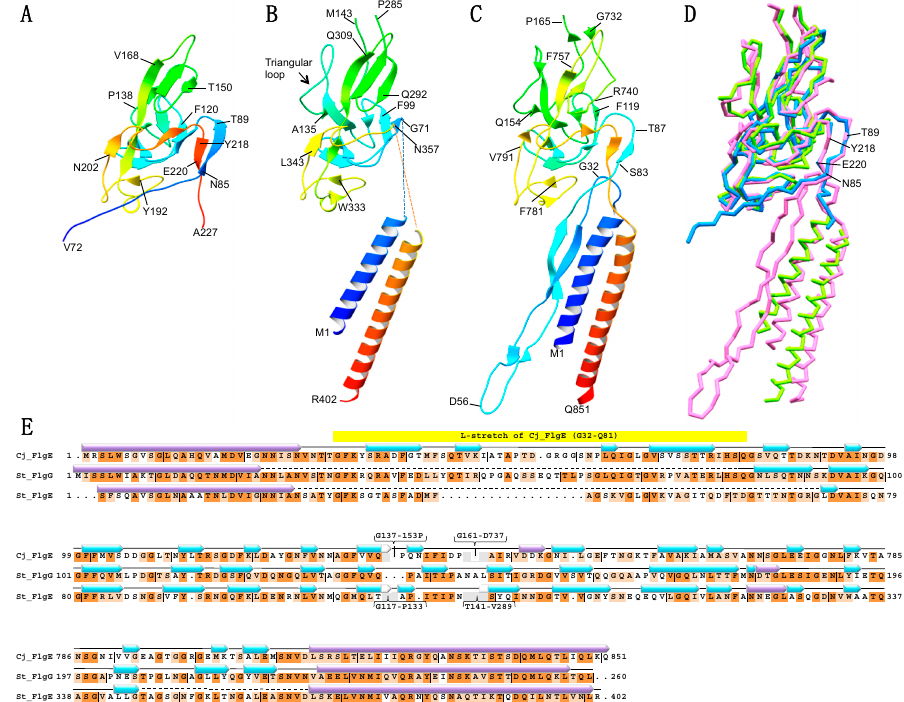
Figure 1. Structure of a core fragment of St-FlgG (FlgG20) from Salmonella typhimurium (St), FlgE from Salmonella typhimurium and FlgE from Campylobacter jejuni (Cj) . Ribbon representation of the crystal structure of FlgG20 ( A ), the cryoEM structure model of D0 and D1 domains of St-FlgE (PDB ID: 3A69) ( B ), and the cryoEM structure of D0, L -stretch and D1 of Cj-FlgE (PDB ID: 5JXL) ( C ). The Dc region of the St-FlgE structure is not modeled due to the low resolution of the cryoEM map in ( B ). The models are color-coded from blue to red through the rainbow spectrum from the N to C terminus. ( D ) The superimposition of backbone models of FlgG20 (blue), St-FlgE (green) and Cj-FlgE (pink). The positions of N85, T89, Y218 and T221 of FlgG20 are indicated. ( E ) Structure-based sequence alignment